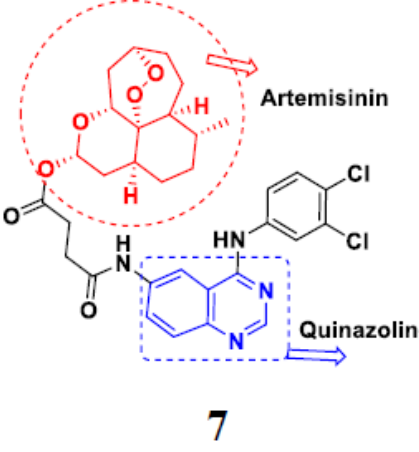
Figure 8. Structure of quinazoline ‐ artemisinin based hybrid 7.